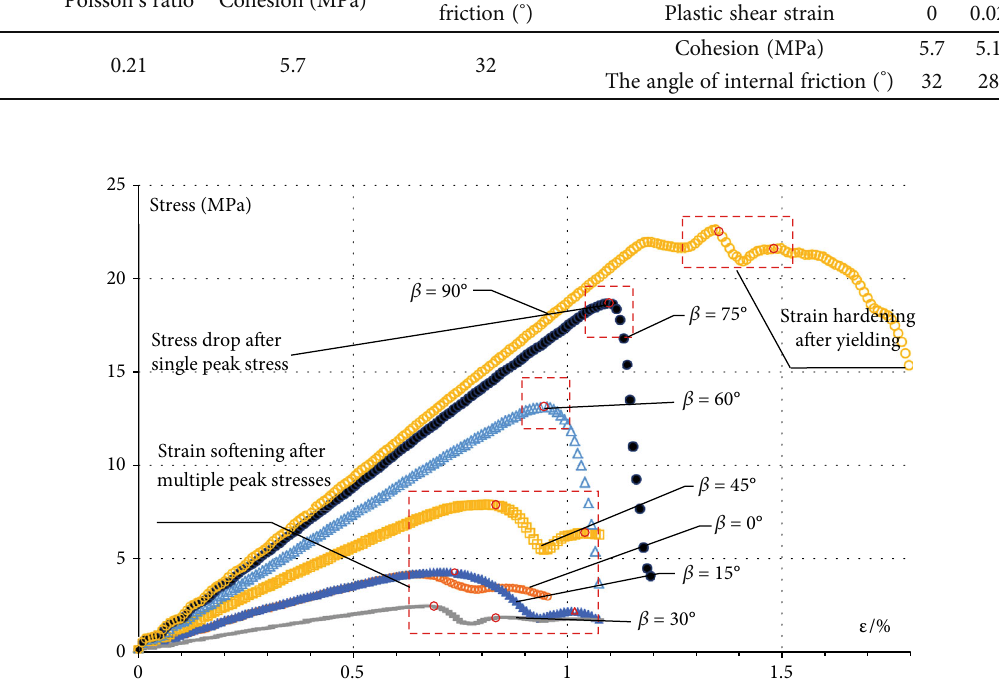
Figure 6: The complete stress-strain curves of PFN-containing rock mass with di ff erent β